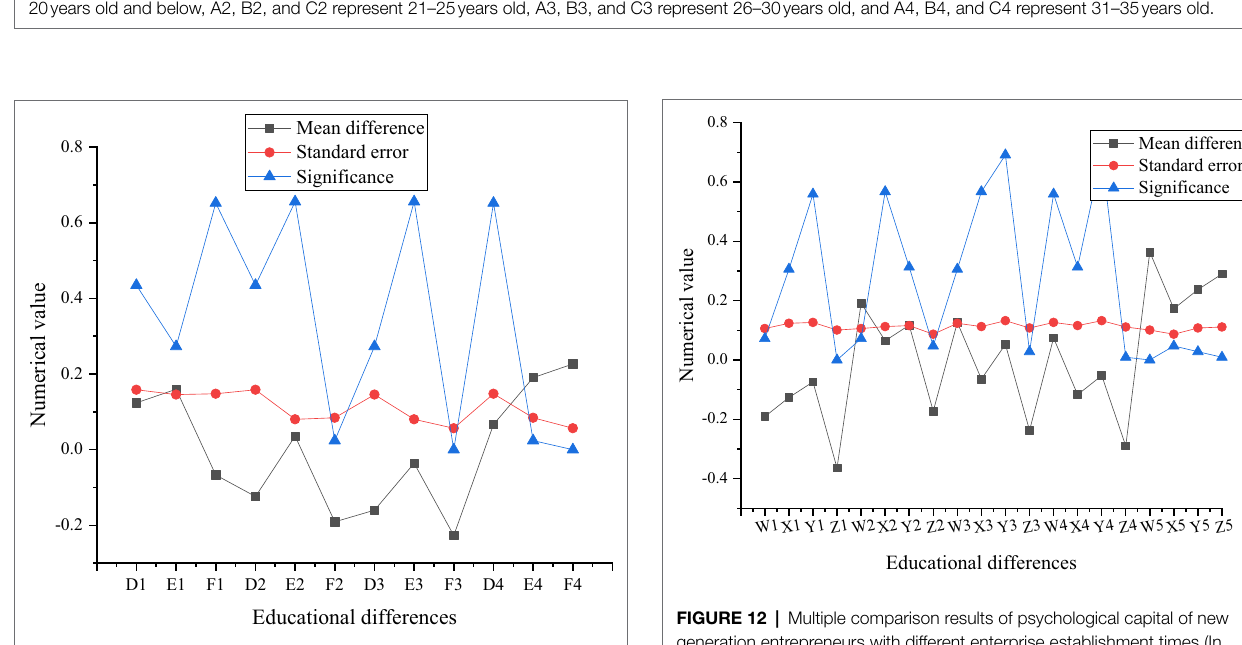
FIGURE 10 | Multiple comparison results of psychological capital and entrepreneurial performance under different ages (A) shows the comparison results of psychological capital under different ages; (B) shows the comparison results of entrepreneurial performance under different ages, in which A1, B1, and C1 represent 20 years old and below, A2, B2, and C2 represent 21–25 years old, A3, B3, and C3 represent 26–30 years old, and A4, B4, and C4 represent 31–35 years old.